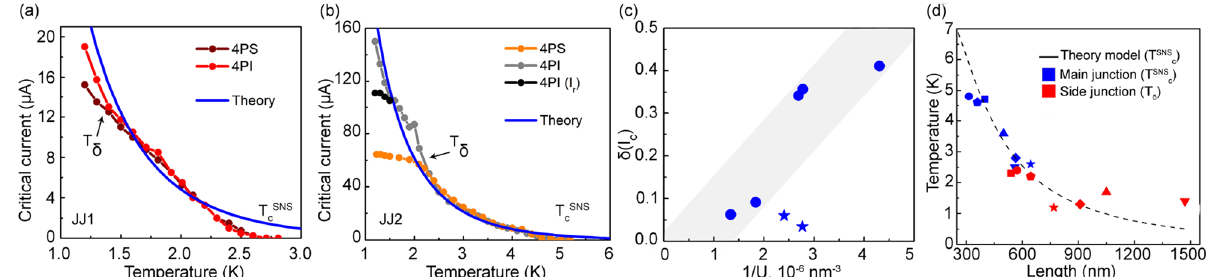
Figure 2. ( a , b ) are I c ( T ) dependencies of the weak links JJ1 and JJ2, respectively, measured using different schemes. The blue lines are fits by Usadel theory. T SNS c is the critical temperature of the JJ, T δ is the temperature below which I c ( T ) curves depend on the measurement scheme (see in the text); the temperature dependence of retrapping current is shown with black dots. ( c ) The relative critical current difference δ( I c ) plotted as a function of the inverse volume of the weak link, 1/ U . ( d ) Dashed line: expected theoretical dependence of T SNS c on the JJ length L . Blue symbols: experimentally measured T SNS c ( L ) . Different symbol shapes denote different junctions. Red symbols: measured T δ of the same junctions presented at positions corresponding to the lengths of their respective side junctions (see explanation in the